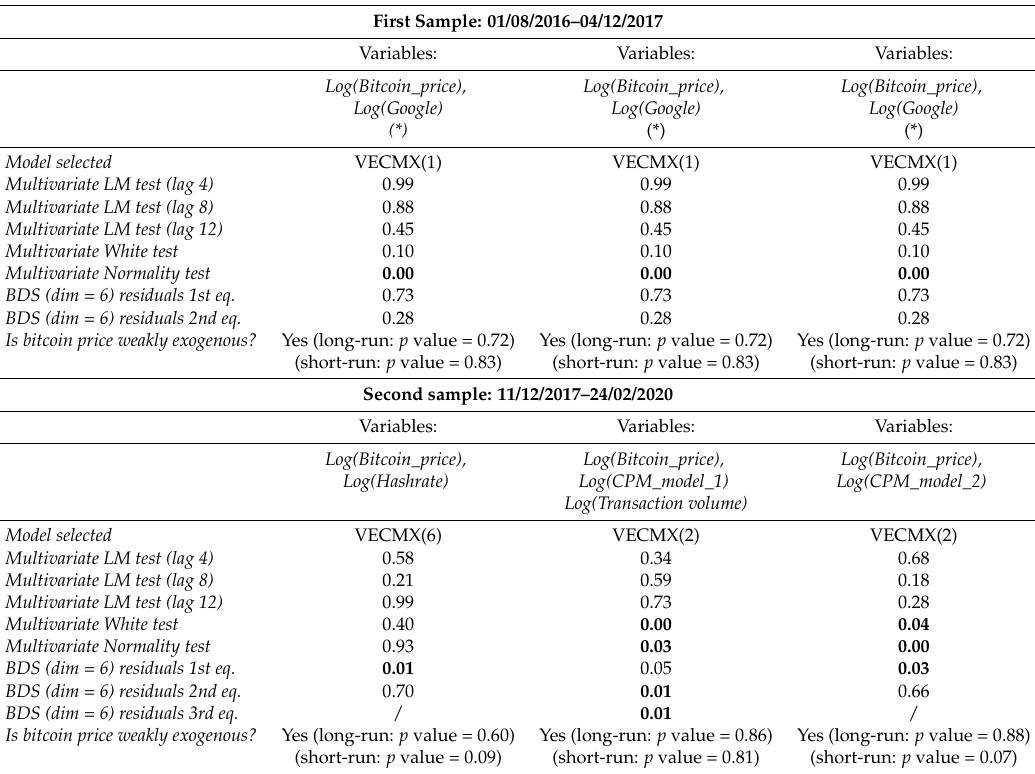
Table 8. Misspecification tests on the residuals from the multivariate models. p -values smaller than 5% are reported in bold font. (*) The final model turned out to be the same, independently of whether we used the hashrate, or the CPM1, or the